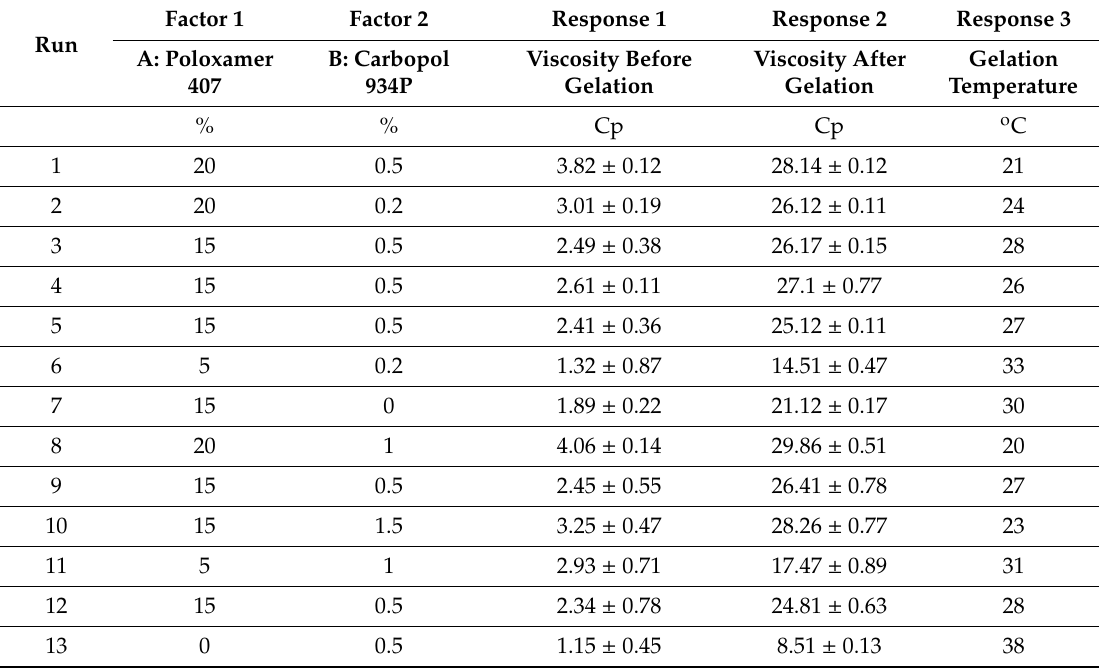
Table 6. RO-EA NTS loaded in situ gel formulation compositions with their observed responses.